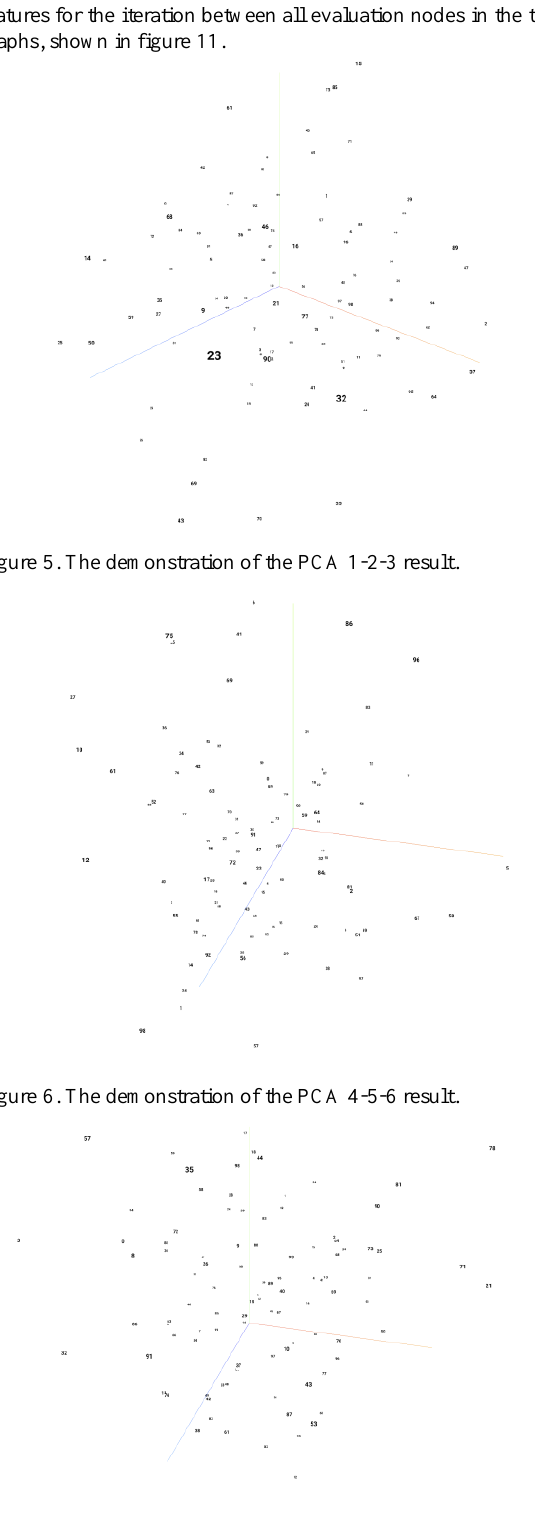
Figure 7. The demonstration of the PCA 7-8-9 result.